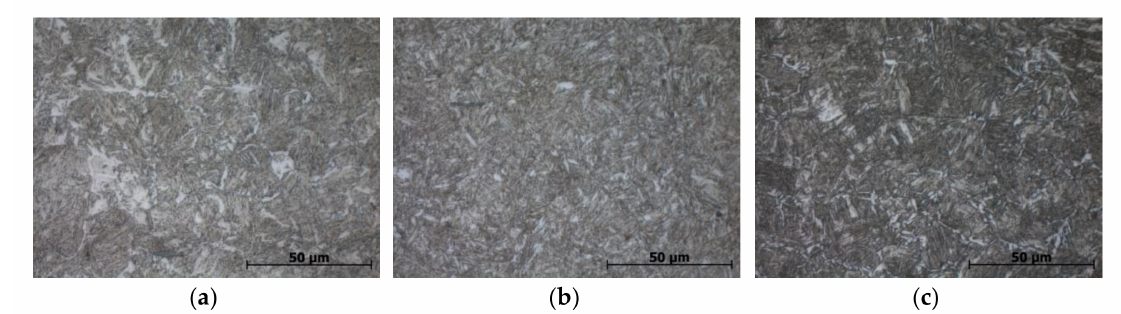
Figure 1. Microstructure of the investigated materials: ( a ) L80; ( b ) 42CrMo4; ( c ) P110.